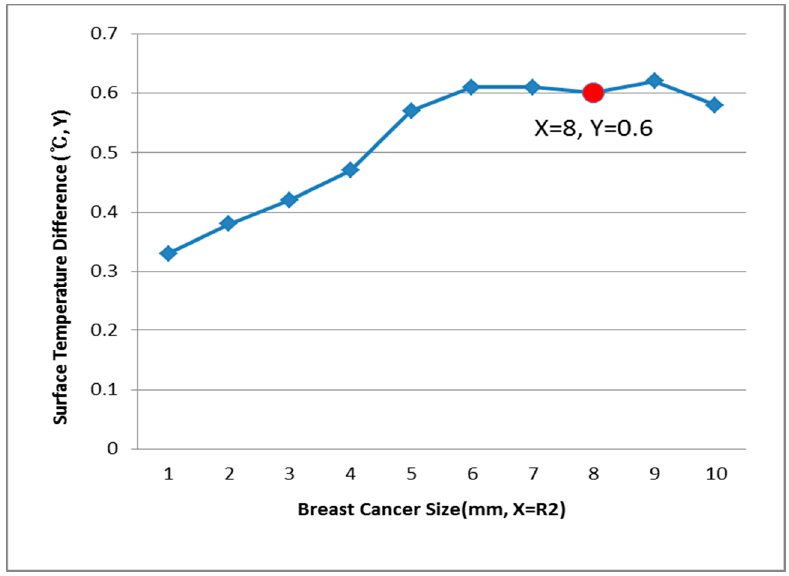
Figure 17. Surface temperature difference for an R1 of 80 mm (X = 0, Y = 10).